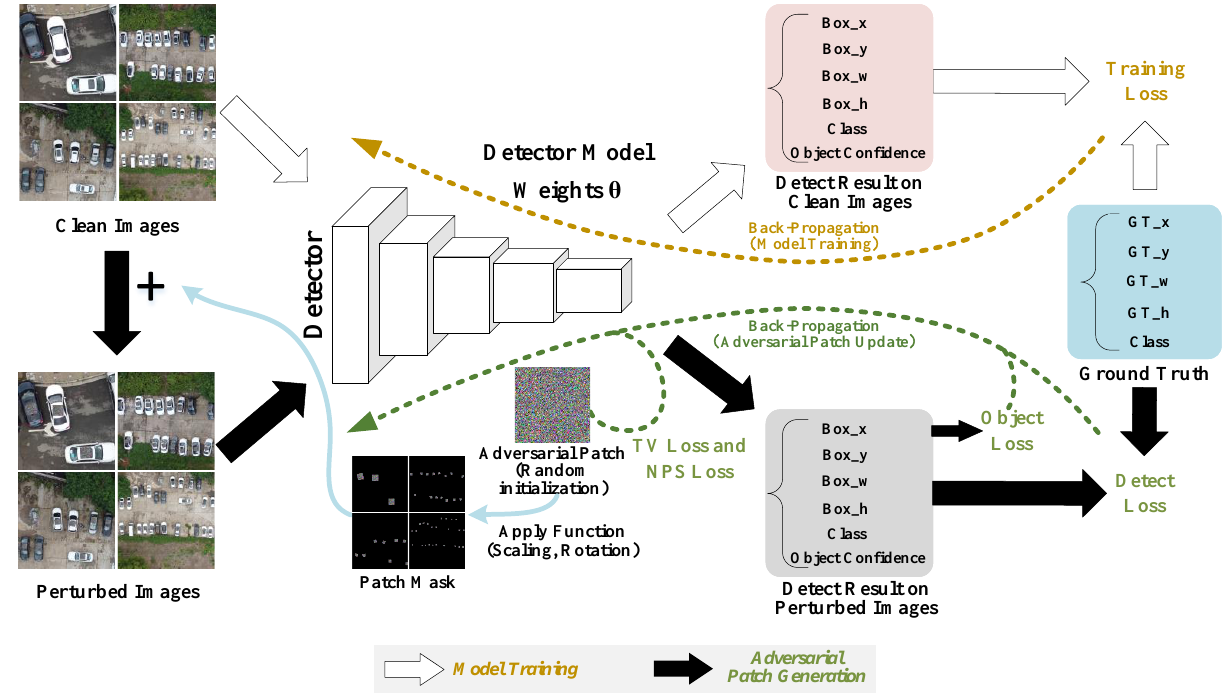
Figure 2. The flowchart of the proposed method. The whole process consists of two parts: Part 1: Detection model training. This includes the optimization of the model’s weights. Part 2: Generating adversarial patch. First, the optimized adversarial patch is scaled, rotated, and attached to clean images, to generate perturbed images with the apply function. Second, the adversarial patch is continuously updated through the gradient ascent algorithm to minimize the loss function, which is the sum of four parts (object loss, detection loss, non-printability score (NPS) loss, and total variation (TV)